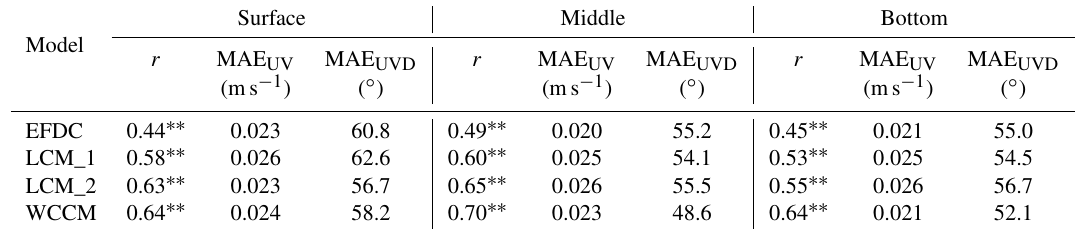
Table 3. Correlation coefficient ( r ) and mean absolute error between the simulated and measured current velocity (current speed, MAE UV ; current direction, MAE UVD ) during the 2015 summer observation for the numerical experiments. Note that * indicates p< 0 . 05 and that ** indicates p< 0 . 01.